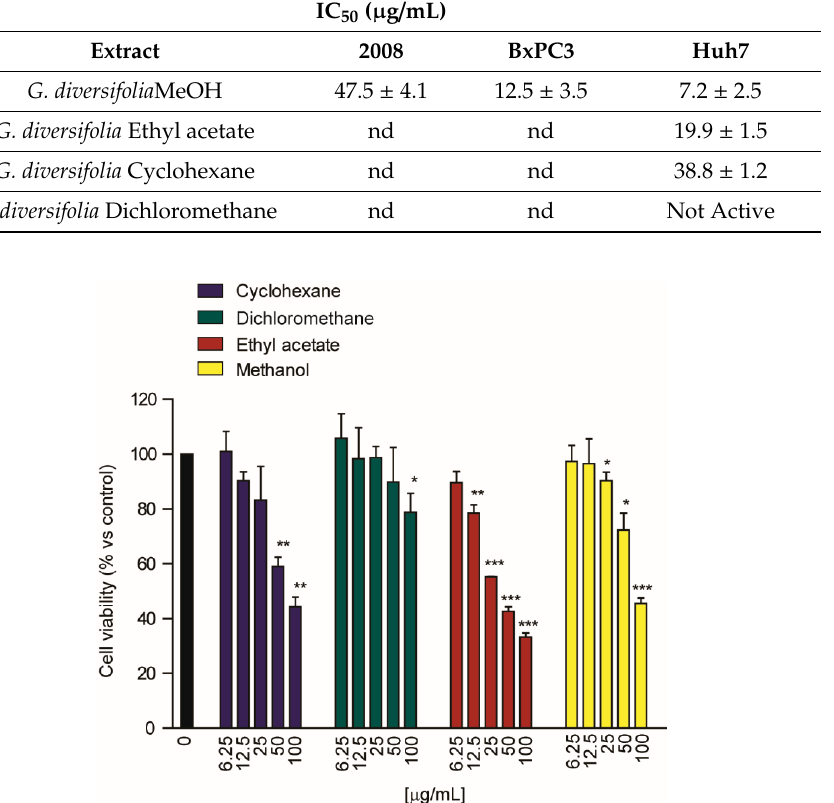
Table 7. Tests of extracts of G. diversifolia on 2008, BxPC3 and Huh7 cell lines (nd: not determined).